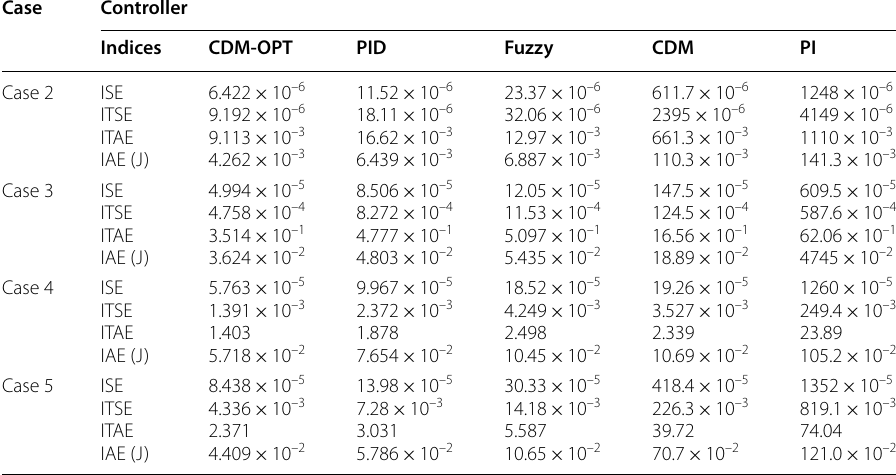
Table 5 Responses analysis in cases